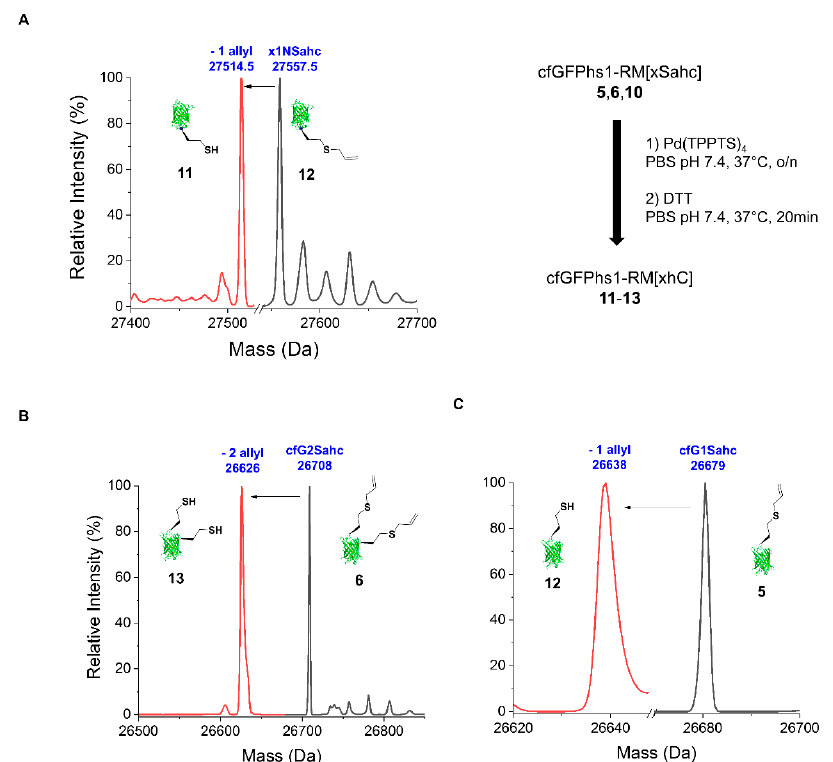
Figure 2. Mass spectrometric profiles of the deallylation reaction catalysed by Pd(TPPTS) 4 catalysis. ( A ) cfGFPhs1-RM(1Sahc) (x1NSahc) 10 (calculated MW: 27558.99 Da; detected MW: 27557.51 Da) with N-terminal handle, ( B ) cfFPhs1-RM(134Sahc:143Sahc) (cfG2Sahc) 6 (calculated MW: 26707 Da; detected MW: 26707 Da) with two in frame handles, ( C ) cfGFPhs1-RM(134Sahc) (cfG1Sahc) 5 (calculated